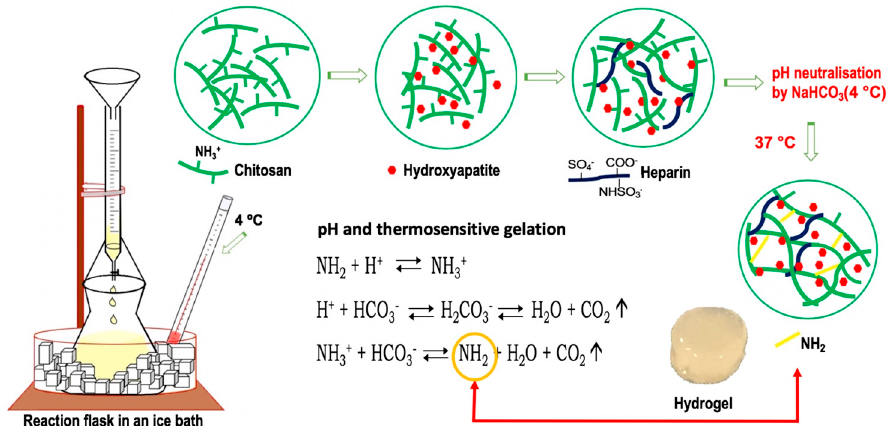
Figure 14. Schematic illustration of synthesis steps of pH dependant ionically crosslinked mechanism of bioactive composite based thermosensitive hydrogels (CS/HA/Hep).